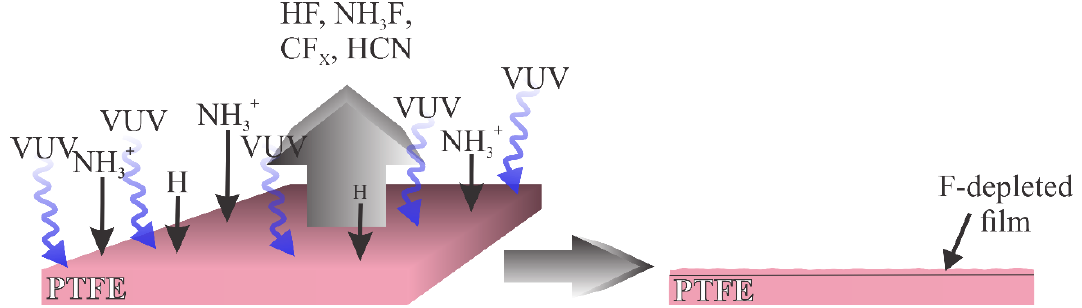
Figure 8. Schematic of the interaction between plasma rich in VUV radiation and PTFE.